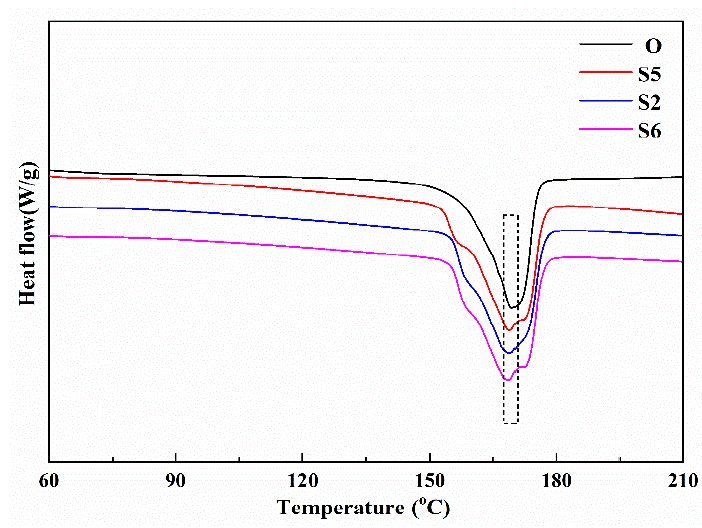
Figure 7. The DSC curves of the membrane samples stretched with different stretching rates.